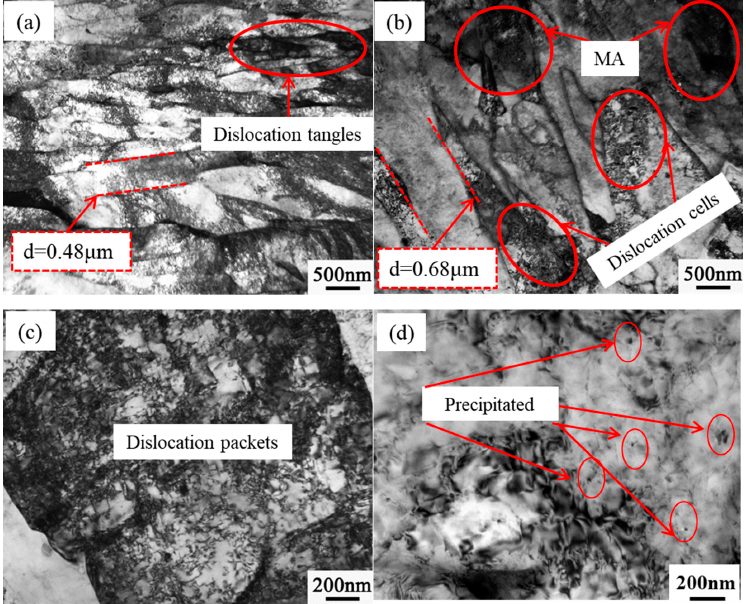
Figure 3. TEM figures of X100 pipeline steel: ( a , b ) lath structure with lots of dislocations in bainite ferrite; ( c , d ) lath and dislocation structures with nanoprecipitations in granular bainite.